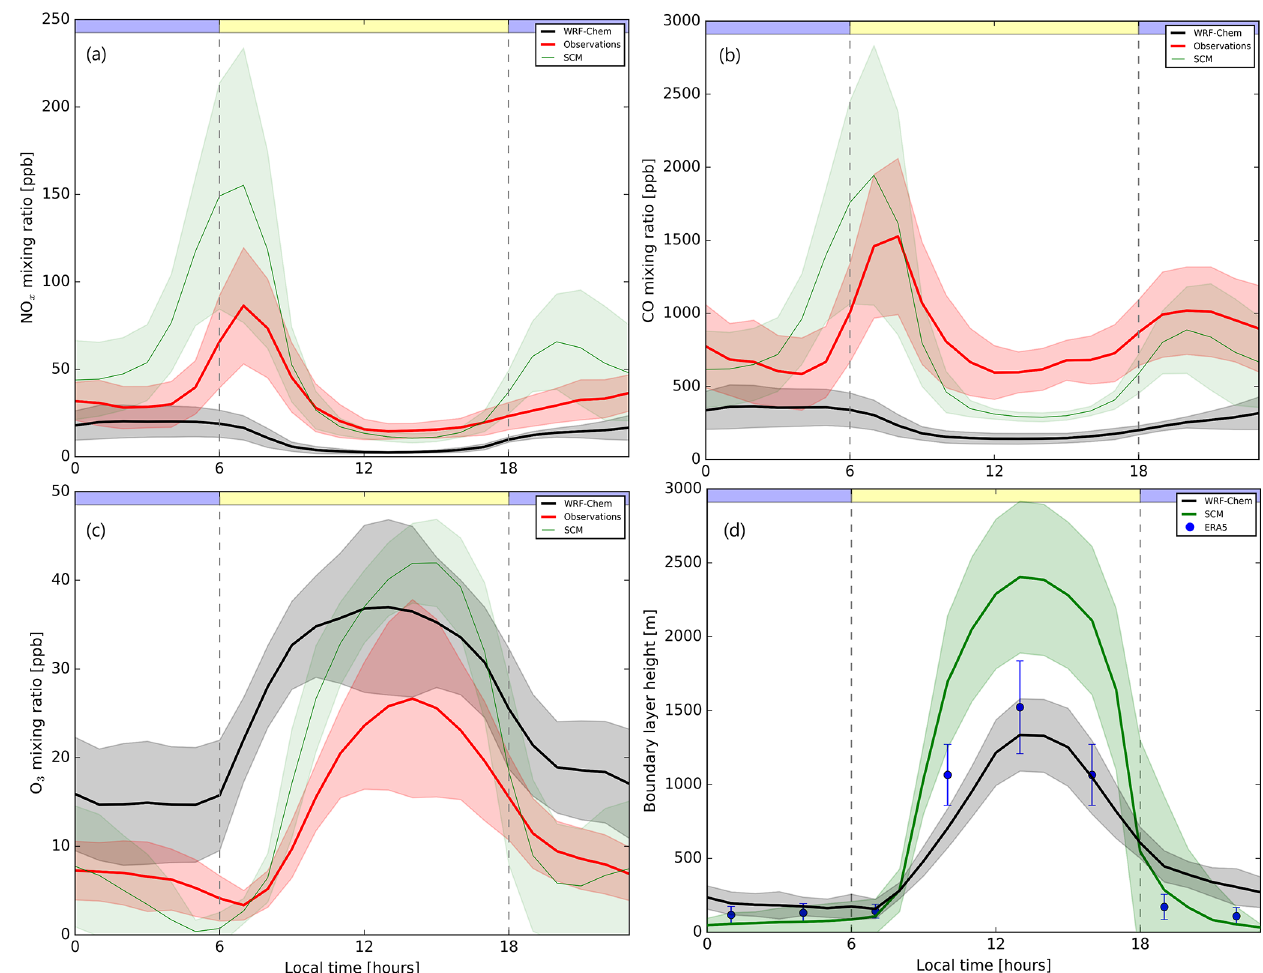
Figure 7. Averaged diurnal cycle of (a) NO x , (b) CO and (c) O 3 mixing ratios (ppb) and (d) boundary layer height (m) in Bogotá for WRF-Chem (black solid line), averaged observational data (red solid line), SCM (green solid line) and ERA5 reanalysis data (blue dots). The black, red and green shadings and blue error bars indicate the 30d standard deviation of WRF-Chem, observations, SCM and ERA5, respectively. The vertical lines and blue (night) and yellow (day) shading indicate daytime and